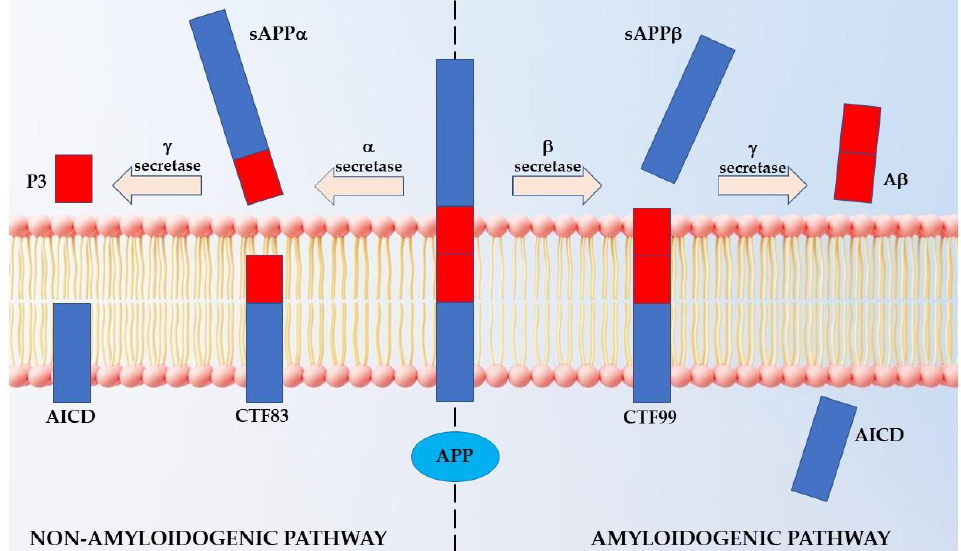
Figure 1. Amyloidogenic and nonamyloidogenic processing of the APP protein under physiological conditions. The region giving origin to the Aβ fragment is highlighted in red.